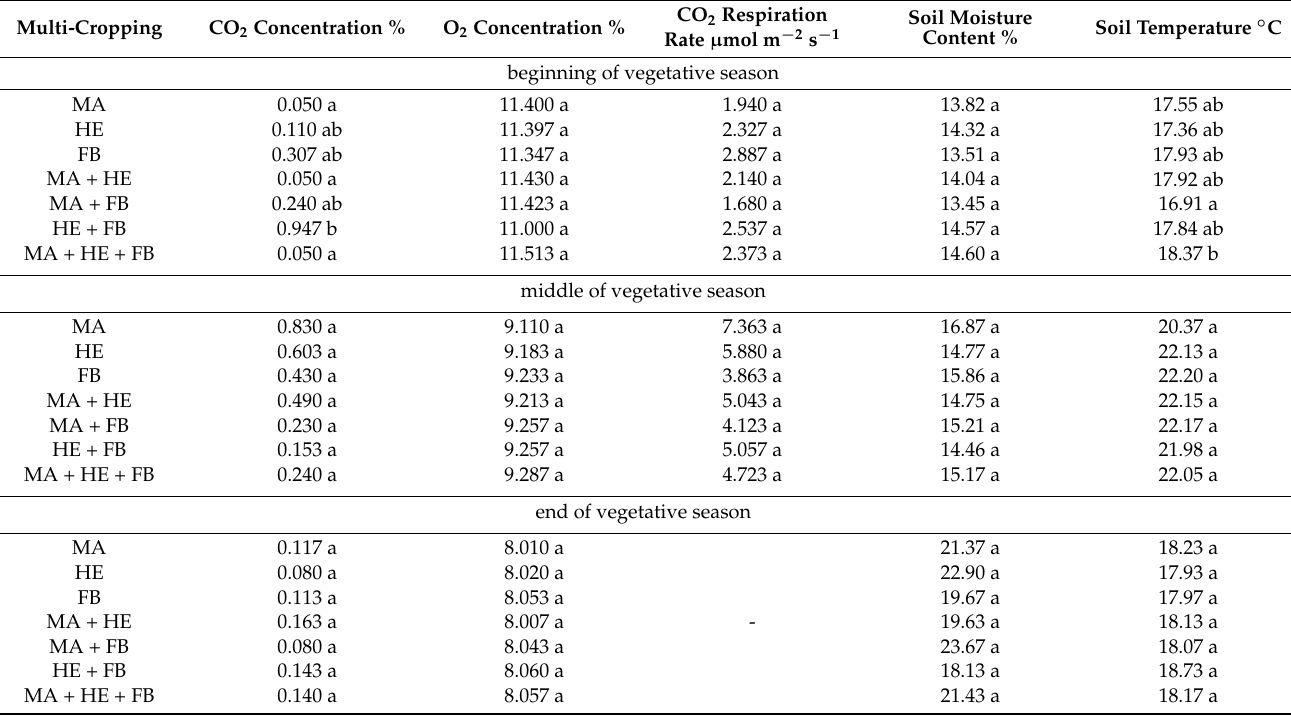
Table 4. Impact of multi-cropping on soil gas concentration, respiration and soil